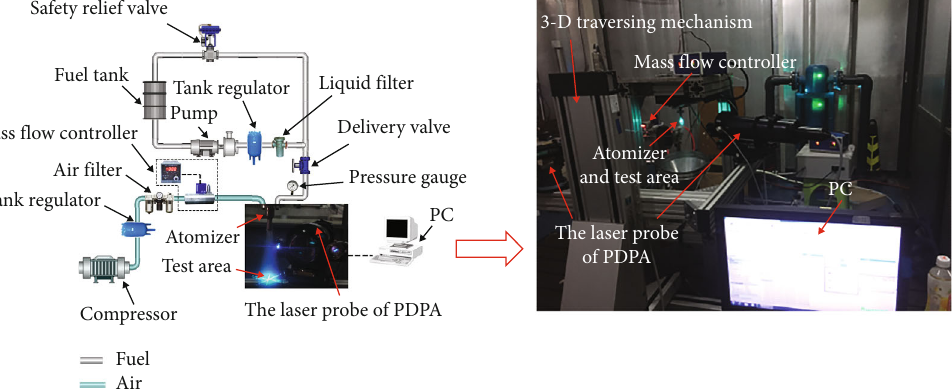
Figure 3: Experimental layout for the integrated measurement system.